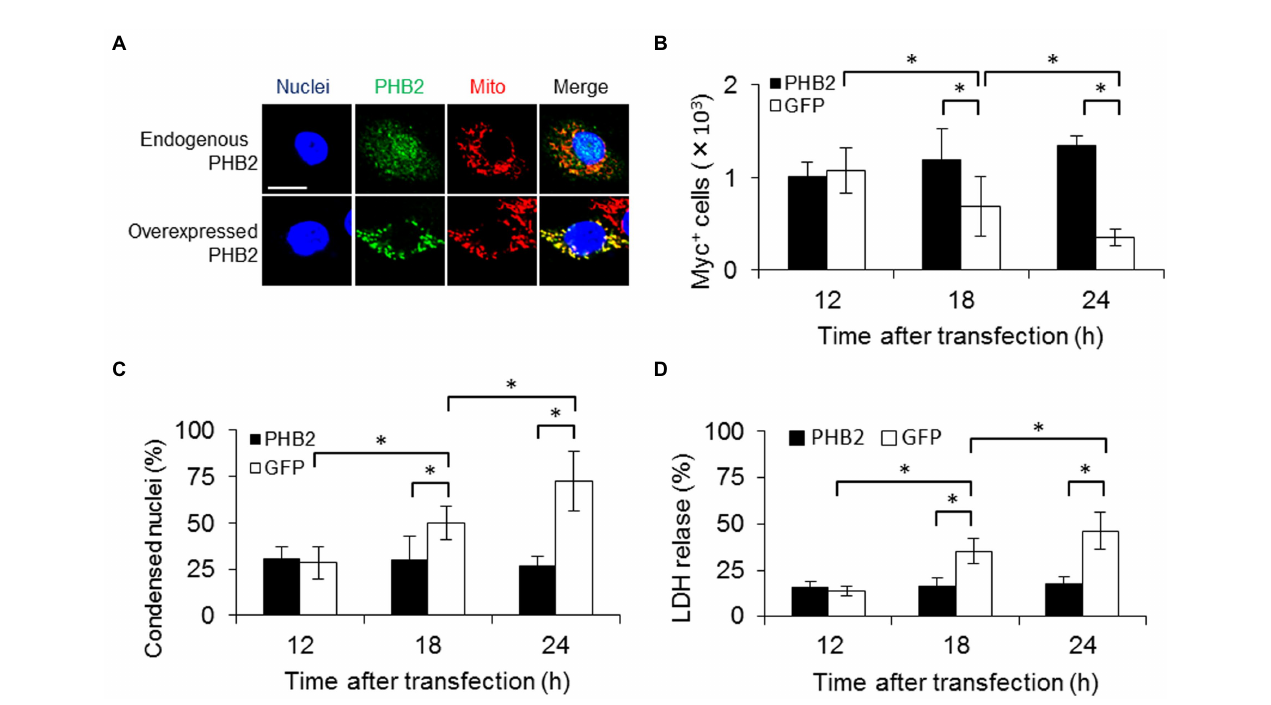
FIGURE 3 PHB2 overexpression reduces apoptosis of PE_PGRS30-expressing cells. (A) Localization of overexpressed PHB2 in cells. RAW264.7 cells were transfected with PHB2-FLAG expression vector. Cells were stained with Hoechst 33342 (for nuclei), MitoTracker Red CMXRos (for mitochondria) and antibodies (for PHB2) at 24 h post-transfection. Anti-PHB2 or anti-FLAG-tag antibodies were used to detect endogenous PHB2 or overexpressed PHB2-FLAG, respectively. Scale bar, 10 μ m. (B) Numbers of PE_PGRS30-expressing cells in PHB2-overexpressing cells. PE_PGRS30-Myc expression vector and PHB2-overexpression or control GFP-expression vector were transfected into RAW264.7 cells simultaneously. Numbers of PE_PGRS30-expresing cells in PHB2-overexpressing cells or in control GFP-expressing cells were counted at the indicated time points. (C) Proportions of PE_PGRS30-expressing cells with condensed nuclei in PHB2-overexpressing cells. Cells were stained with Hoechst 33342 at the indicated time points. Numbers of PE_PGRS30-expressing cells with condensed nuclei in PHB2-overexpressing cells were counted and are presented as percentages against total numbers of PE_PGRS30-expressing cells in PHB2- overexpressing cells. (D) LDH levels in culture supernatants of GFP-and PE_PGRS30-expressing cells, and PHB2-and PE_PGRS30-expressing cells. (A–D) Data are representative of three independent experiments. (B–D) Means ± SD are shown. * p < 0.05 using one-way ANOVA with Tukey’s multiple comparisons. More than 100 cells overexpressing PHB2 were counted in each